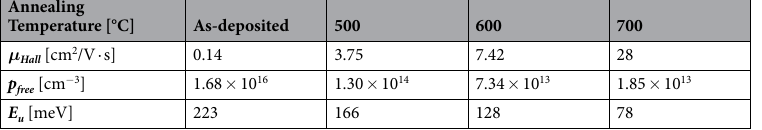
Table 1. Summary of Parameters ( μ Hall , p free and E u ) for Different Annealing Temperatures 8